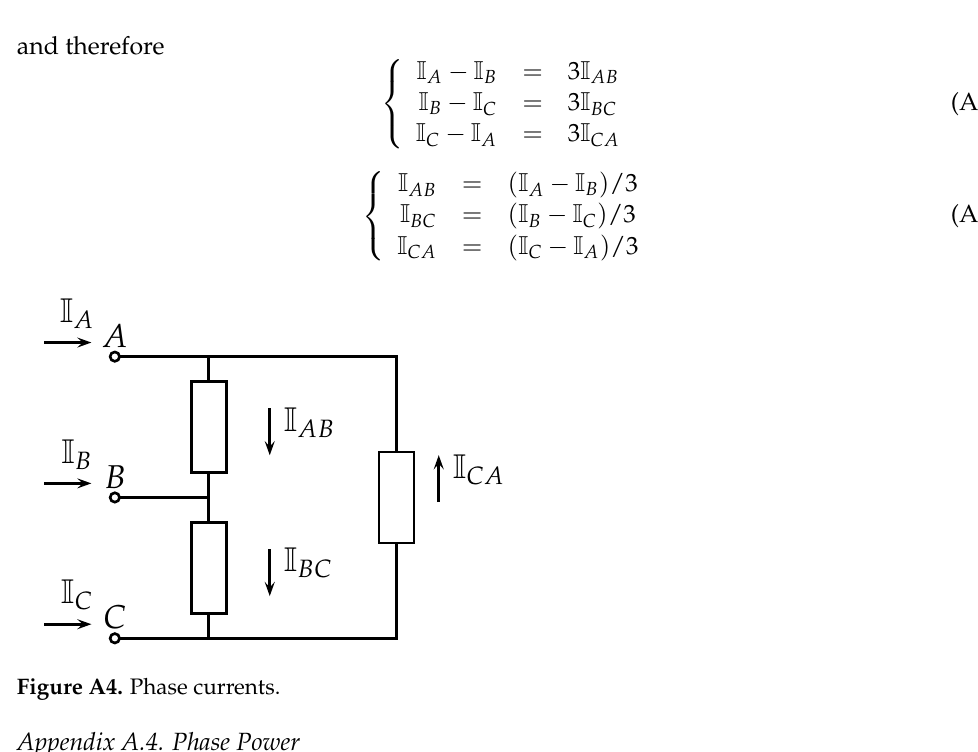
Figure A4. Phase